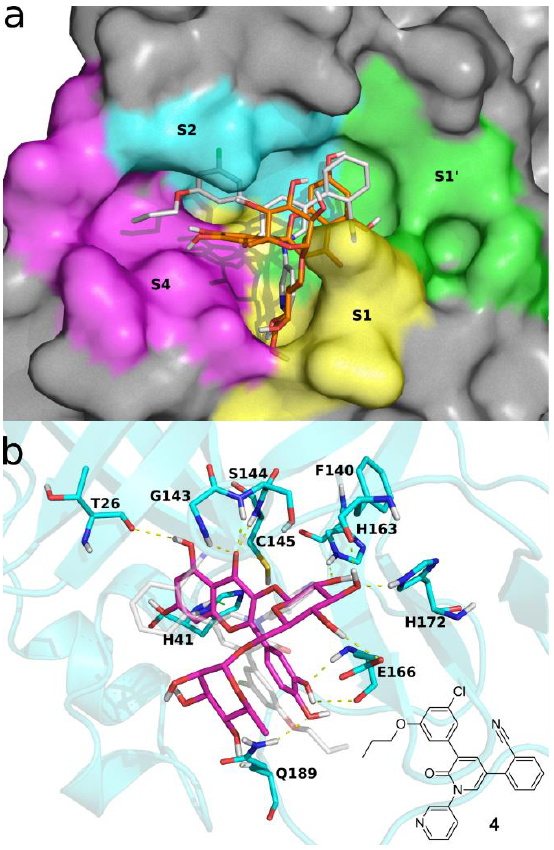
Figure 5. Docking pose of 1 into SARS-CoV-2 Mpro active site. (a) 1 is shown in orange sticks; the molecular surface of Mpro is colored according to the binding sites S1 (yellow), S1′ (green), S2 (cyan) and S4 (magenta). (b) 1 is represented in magenta sticks and SARS-CoV-2 Mpro in cyan cartoons and sticks; dashed lines represent h-bonds (in yellow) and π - π stacking interactions (in green). Experimental bound conformation of 4 (PDB 7L11) [40] is shown in white sticks for reference in both panels. These figures were made using open source PyMOL v.